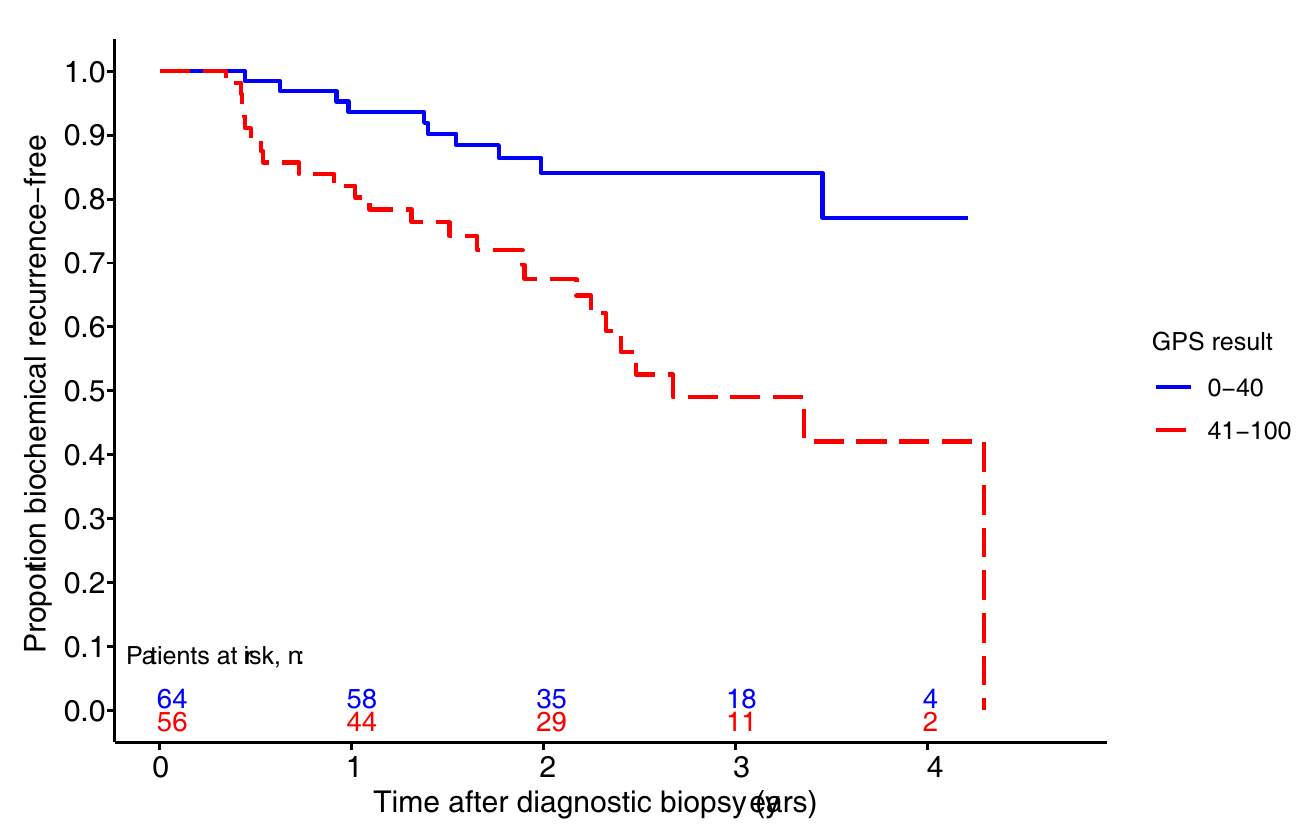
0.00.10.2 Patients at risk, n: Fig 2. Kaplan-Meier curves stratified by GPS result. Kaplan-Meier curves showing the proportion of patients remaining free of biochemical recurrence from time of biopsy stratified by GPS result 0–40 and 41–100 (n = 120).